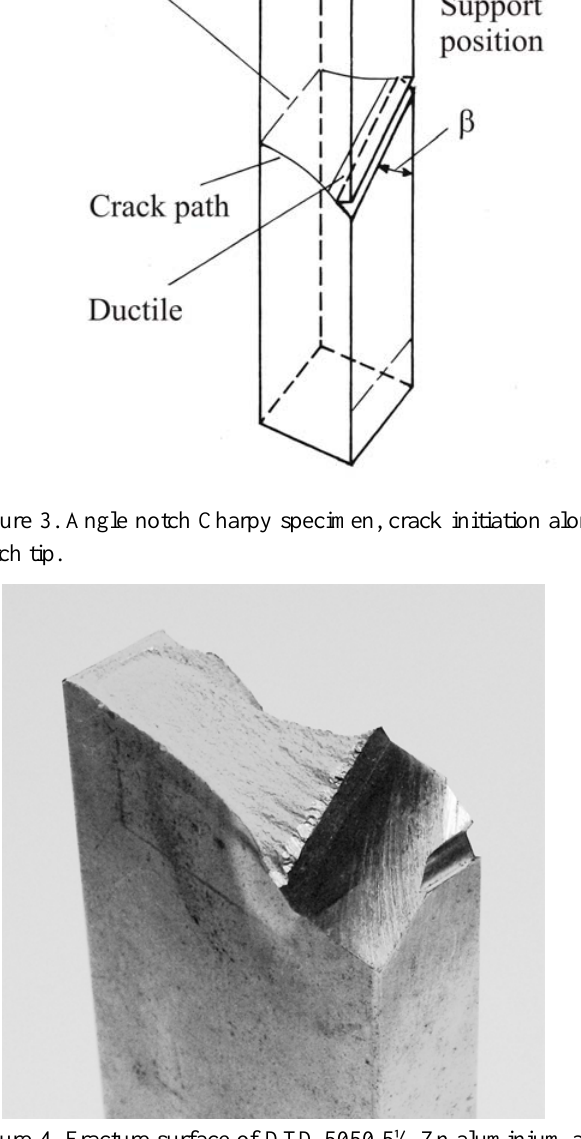
Figure 4. Fracture surface of DTD 5050 5½ Zn aluminium an- gle notch fracture toughness test specimen, initial β = 45 °